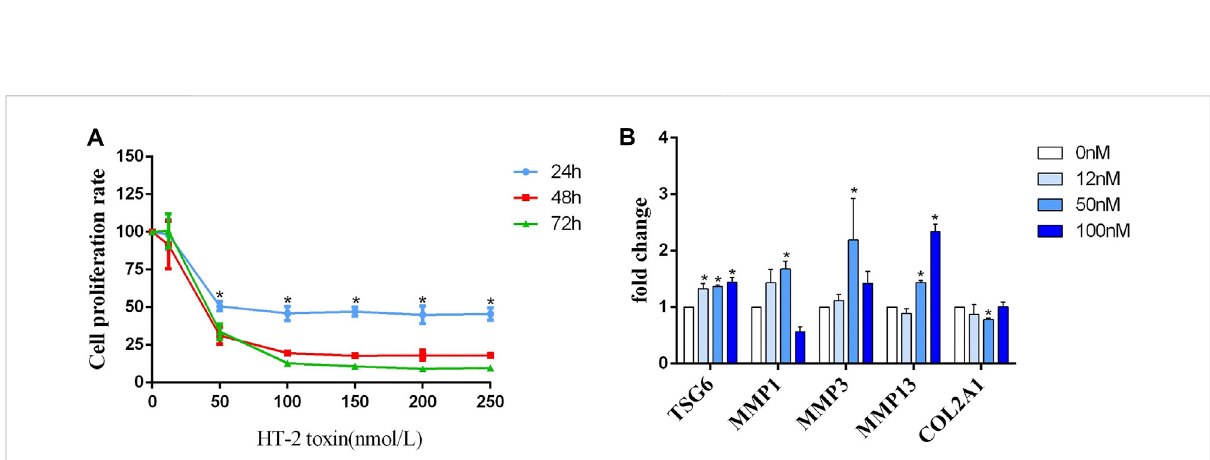
FIGURE 3 (A) The detection of the human C28/I2 cell proliferation rate after treatmentwith differentconcentrations (0,50, 100, 150, 200, and 250 nmol/ L) of HT-2 toxin for 24 h, 48 h, and 72 h; * indicates p < 0.05. (B) The mRNA expression of MMP1, MMP3, MMP13, TSG-6, and COL2A1 after human C28/I2 cells were treated with different concentrations (0, 12, 50, and 100 nmol/L) HT-2 toxin; * indicates p <